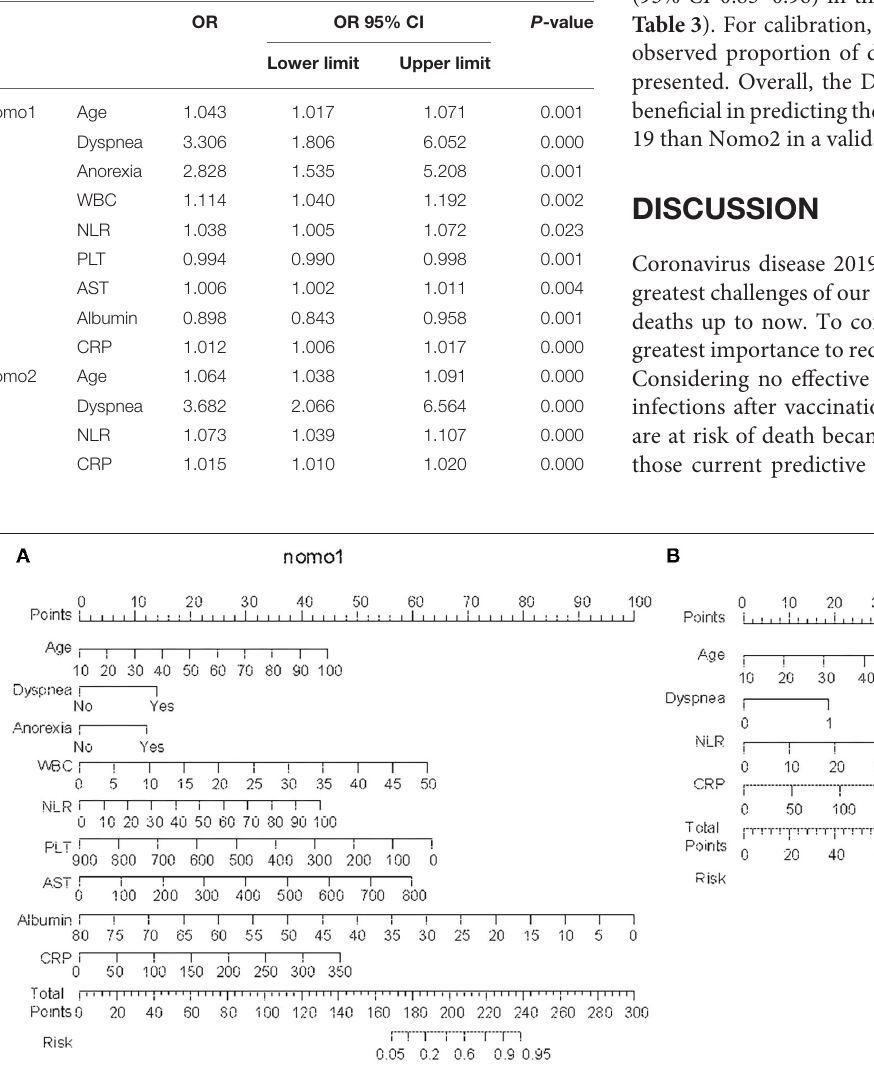
FIGURE 2 | Establishing the nomograms with the identified risk factors. (A) Nomo1 was established by including nine identified independent risk factors. (B) Nomo2 was established by including age, dyspnea, neutrophil-to-lymphocyte ratio (NLR), and C-reactive protein (CRP).